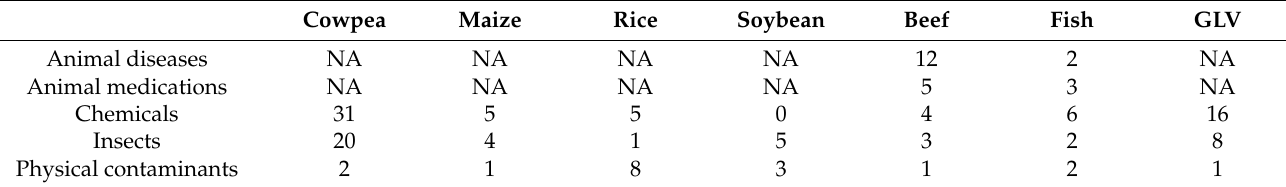
Table 5. Main hazards cited by consumers by type of food.